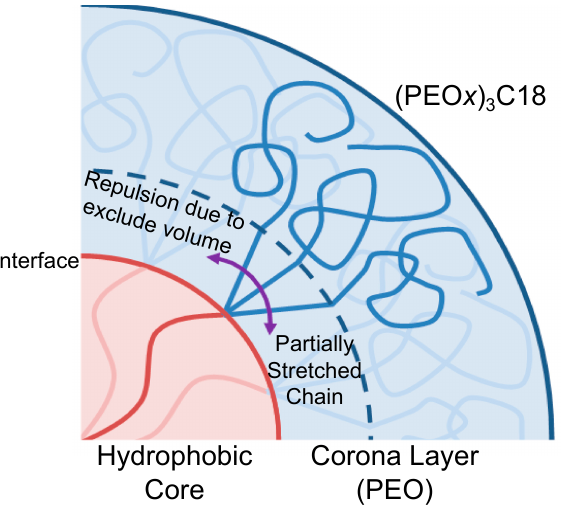
Figure 6. Schematic representation of conformation of PEO chains in (PEO x ) 3 -C18 micelles.